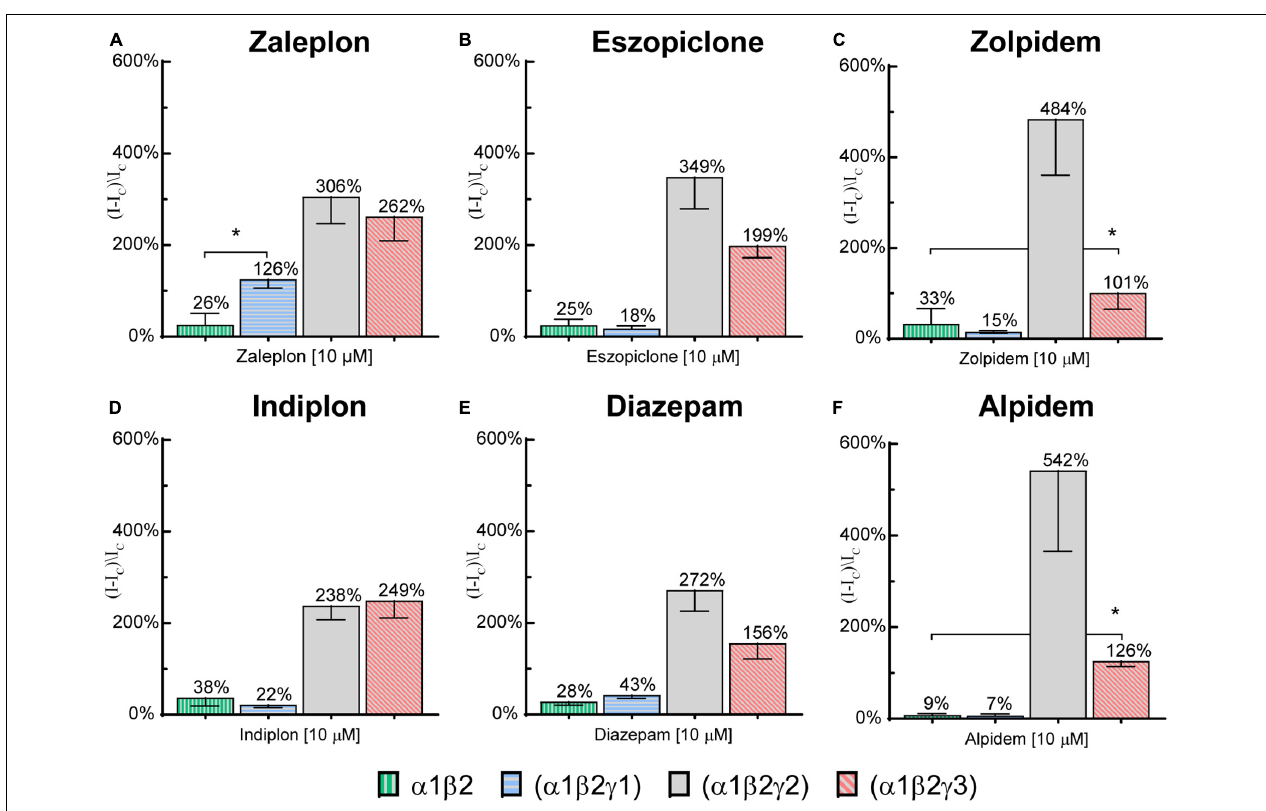
FIGURE 6 | Modulatory actions of 10 µ M (A) zaleplon, (B) indiplon, (C) eszopiclone, (D) diazepam, (E) zolpidem, and (F) alpidem, on GABA evoked Cl − currents measured in human α 1 β 2 γ 1, α 1 β 2 γ 2, α 1 β 2 γ 3, and binary α 1 β 2 GABA A receptors expressed in Xenopus laevis oocytes measured via two-electrode voltage-clamp. Data are expressed as percentage potentiation of GABA EC 10 and are means ± SD ( n = 3–8 from at least 2 separate Xenopus laevis donors). One-way ANOVA with post hoc Sidak multiple comparisons test were calculated between all compounds on γ 1 vs. α 1 β 2 and between zolpidem and alpidem on γ 3 vs. α 1 β 2; * p <